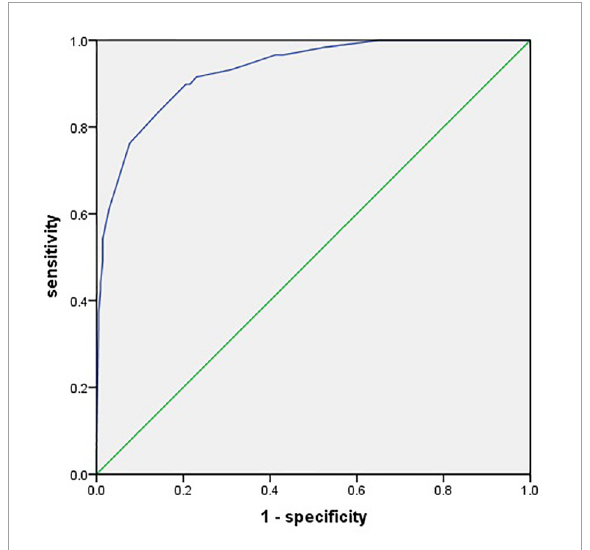
FIGURE3 A receiver operating characteristic (ROC) curve for evaluating the prediction model’s discrimination performance [area under the ROC curve (AUC) =